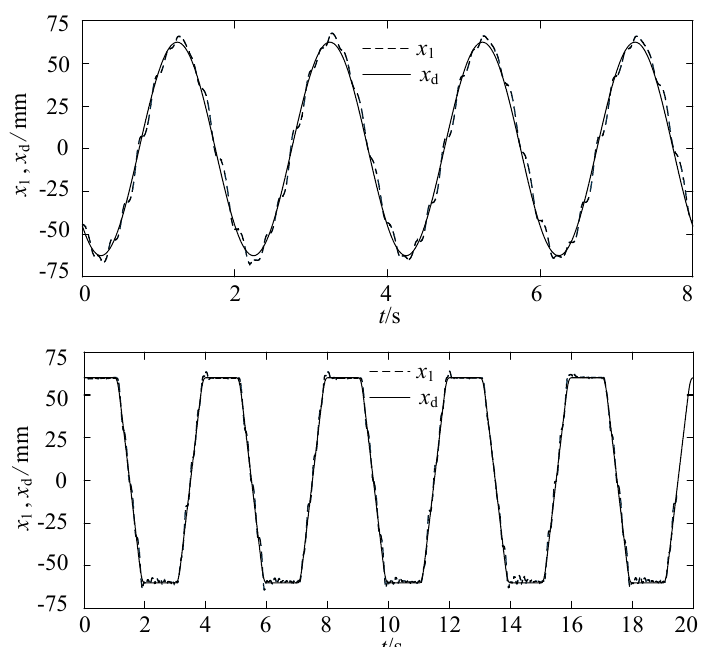
Figure 4. Tracking response of the same control algorithm as the proposed controller but without using long transmission line compensation.